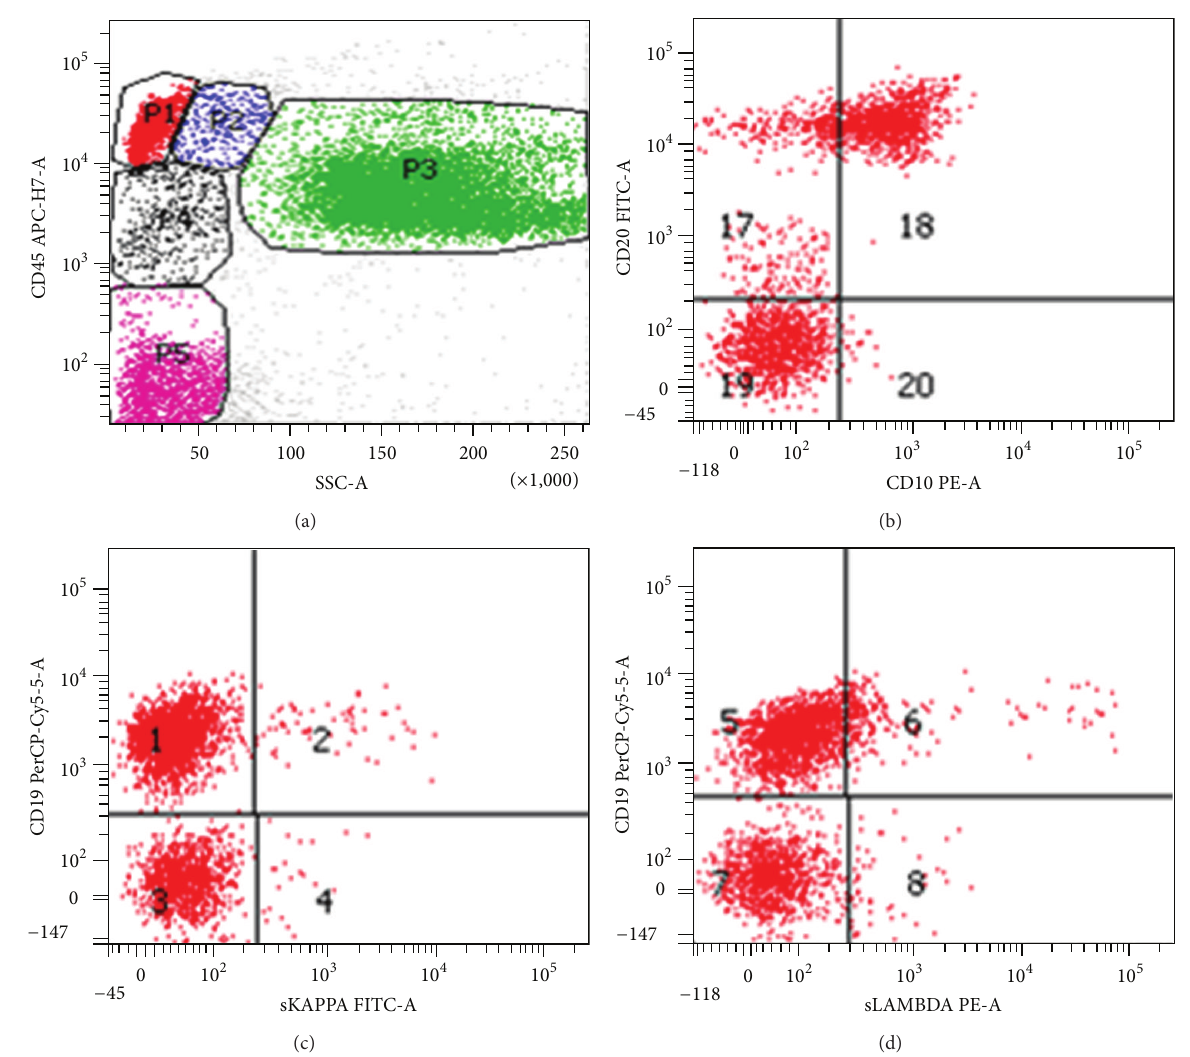
Figure 6: (a) Flow cytometry of the ungated bone marrow aspirate shows 16% cellularity in the CD45 bright/low side scatter gate, (b) gating only the CD45 bright/low side scatter gate shows a population of CD10+/CD20+ lymphocytes representing 7% of overall cellularity, and (c) this population shows dim surface lambda light chain restriction, all findings consistent with a low grade lymphoma of germinal center